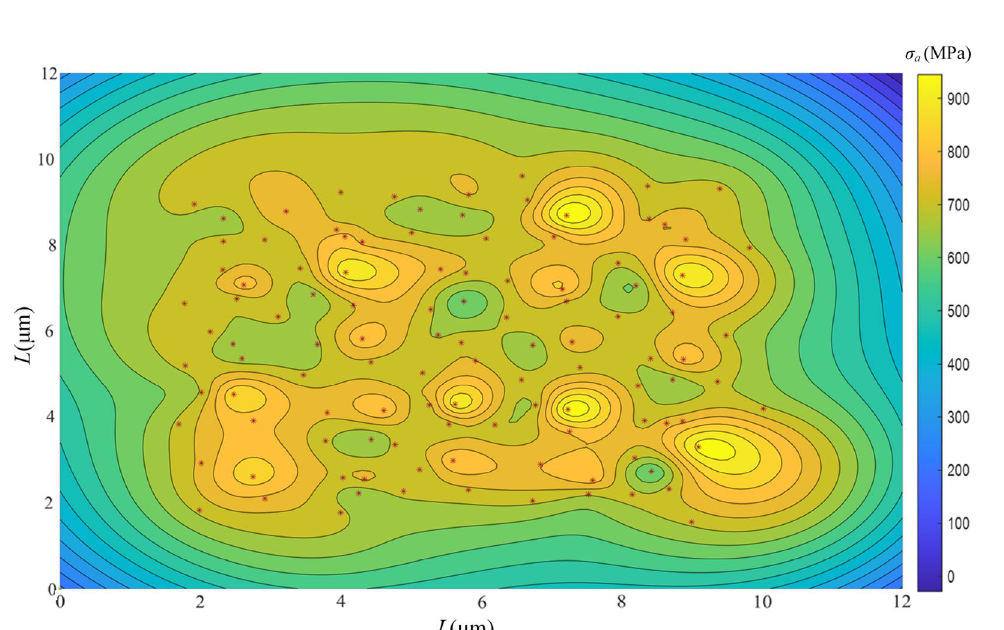
Figure 6 The contour field